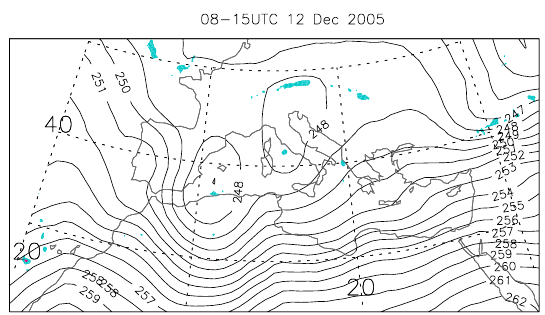
Fig. 13. Same as Fig. 5, but for 12 December 2005, 08:00–